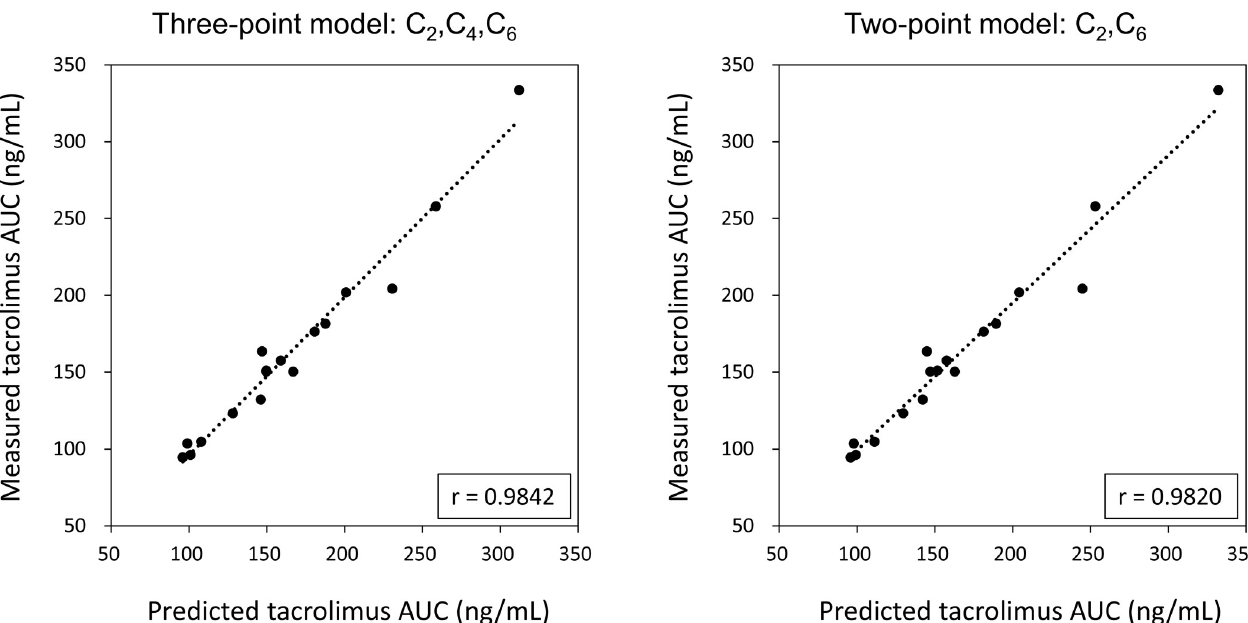
Fig 6. Scatter plots of predictive AUC on the x-axis versus measured AUC on the y-axis. The predicted AUC estimated with a multiple regression equation provided the closest approximation to the actual value of AUC 0-12 using the three time points C 2 , C 4 , and C 6 , and almost exactly the same result was obtained using the two time points C 2 and C 6